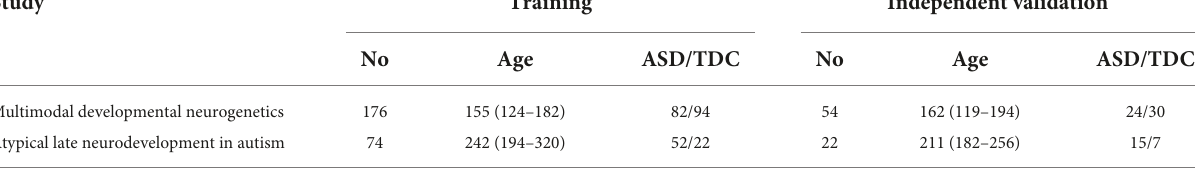
TABLE 2 Distribution of subjects from each cohort among the training/cross-validation versus independent test set, using only data from studies where we found significant ASD-related alterations. Study